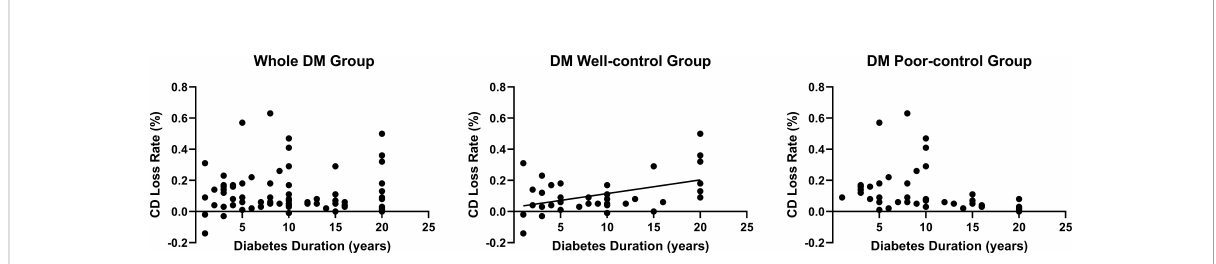
FIGURE 4 The Relationship between Diabetes Duration Time and Cell Density (CD) Loss Rate in Diabetes Mellitus (DM) Patients. The diabetes duration was positively linearly correlated with the CD loss rate in DM well-control group. 9 patients were excluded from the statistical analysis because they were diagnosed with DM at the time of